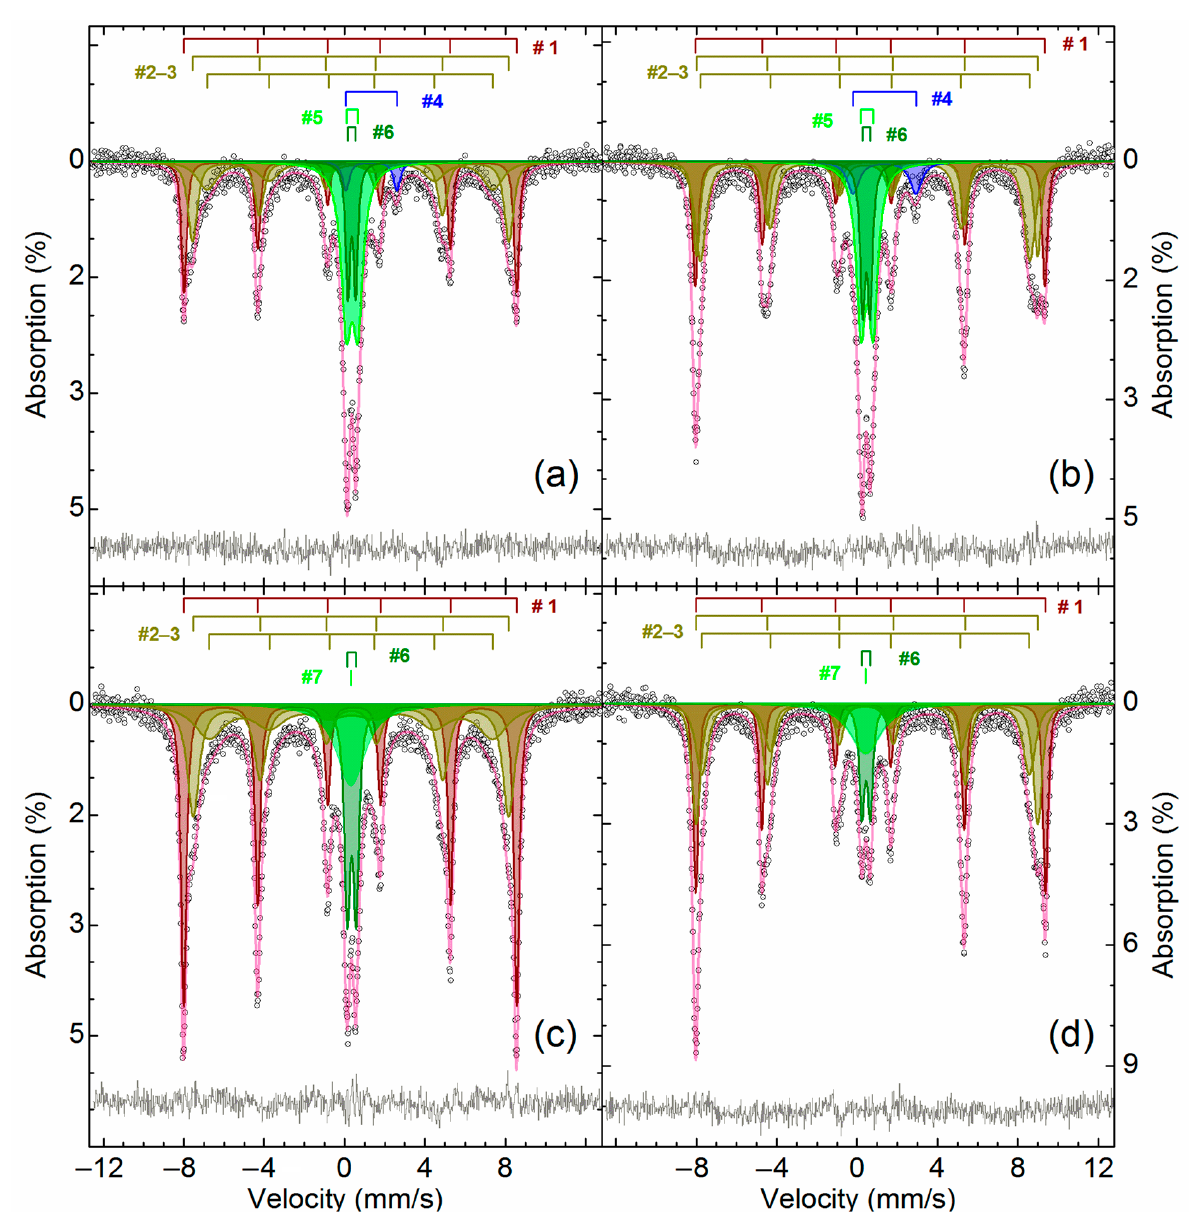
Figure 14. The Mössbauer spectra obtained at 296 K ( a , c ) and 78 K ( b , d ) of ZPR roasted with the addition of 48% Fe 2 (SO 4 ) 3 ∙ 9H 2 O during 180 min at 600 °C ( a , b ), as well as of the same sample after its water leaching ( c , d ). Table 8. Parameters 1 of the illustrated in Figure 14 Mössbauer spectra of ZPR roasted with the addition of 48% Fe 2 (SO 4 ) 3 ∙ 9H 2 O during 180 min at 600 °C, as well as of the same sample after water leaching. Temperature of Spectra Collecting, K Sample Subspectrum, #